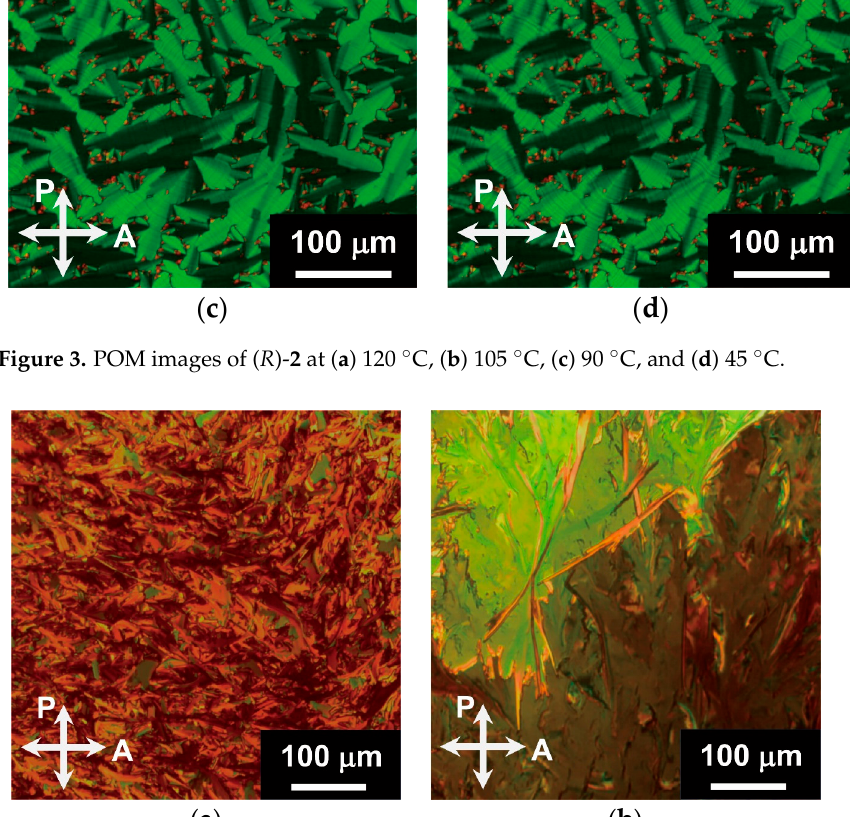
Figure 4. POM images of ( R )- 3 at ( a ) 70 °C, and ( b ) 40 °C.